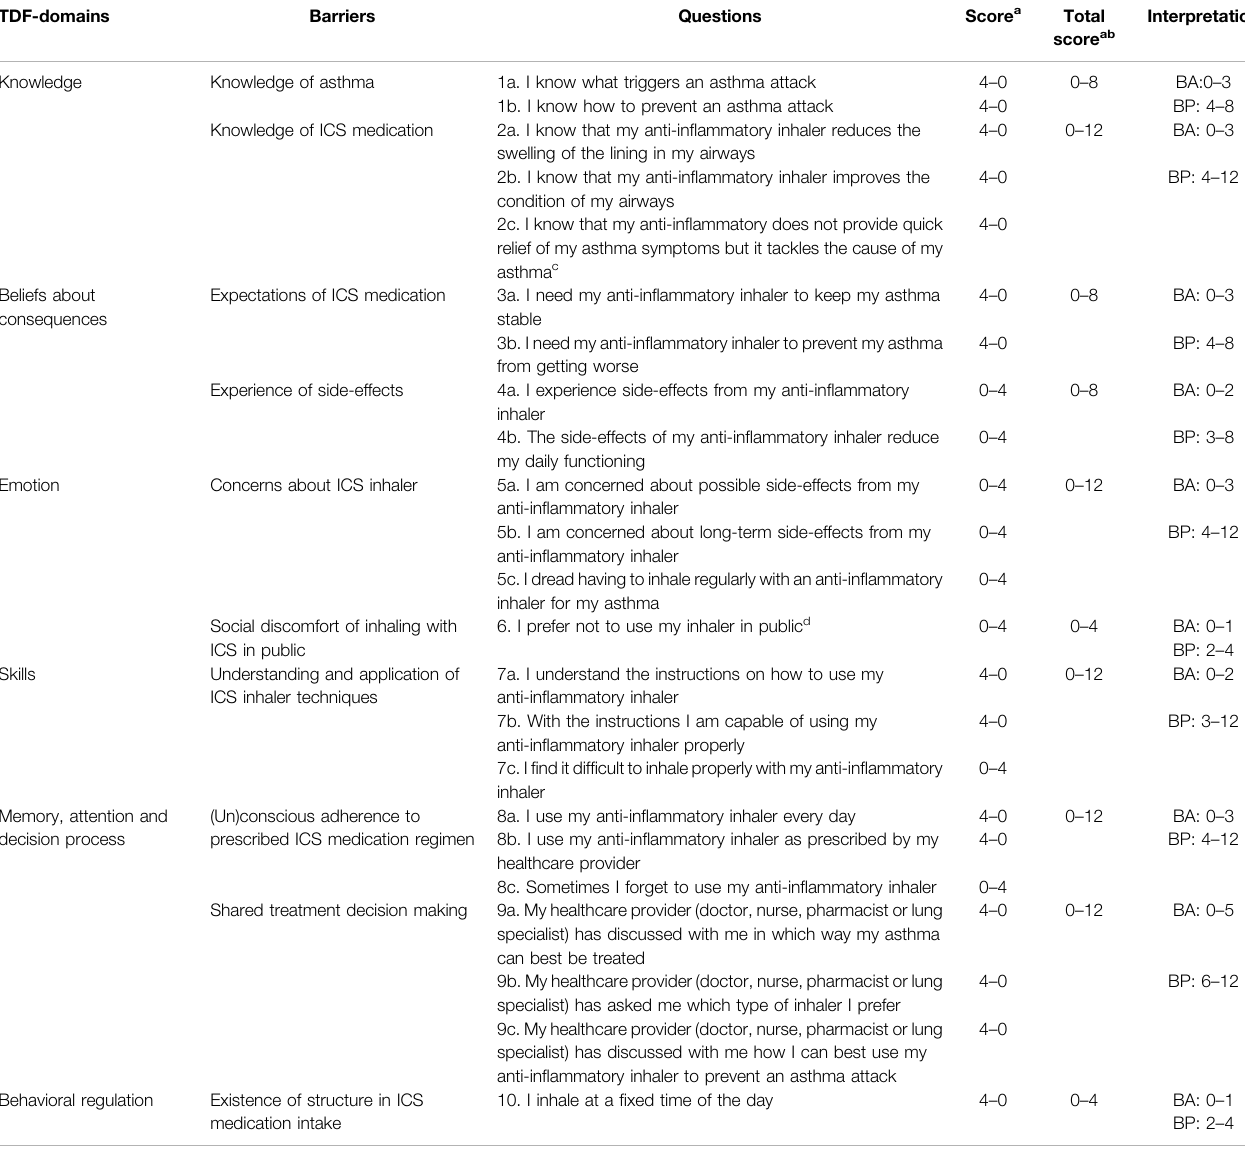
TABLE 4 | Description of the RACE questionnaire identifying individual barriers to self-management of ICS therapy.